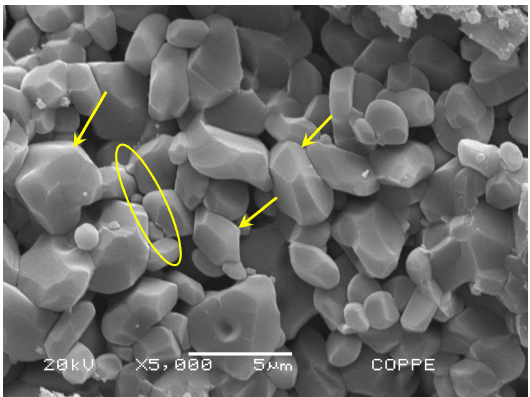
Figure 6. Fracture region of a sisal composite caused by fragments (projectile/ceramic) after the ballistic impact. Arrows indicating brittle epoxy